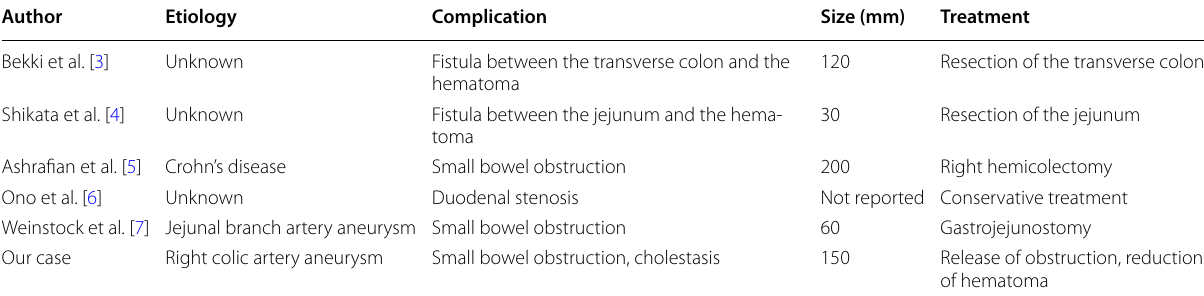
Table 1 Reported cases of complications of a non-traumatic mesenteric